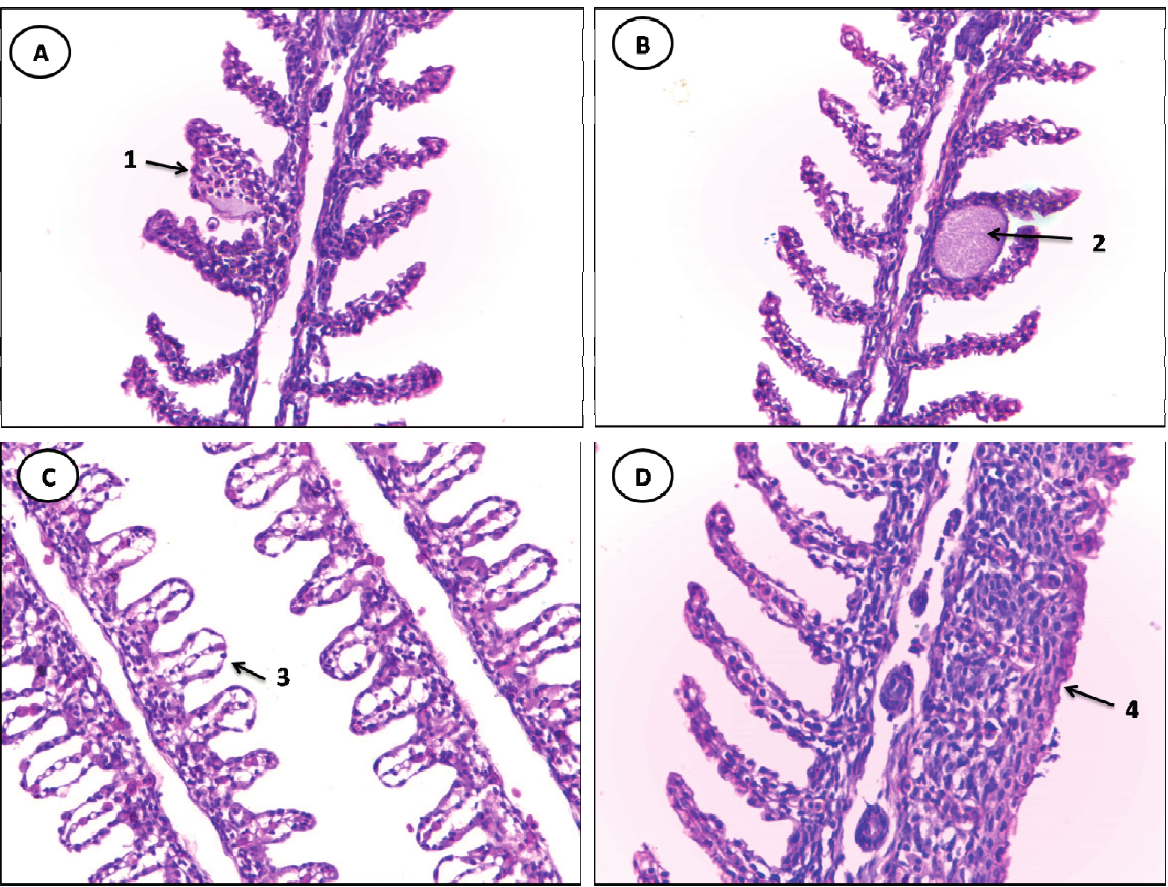
Figure 3. Histological alterations in the gills of Sardinella sp. ( A ) 1: aneurysm. ( B ) 2: parasitic cyst. ( C ) 3: lifting of the respiratory epithelium. ( D ) 4: complete fusion of several lamellae (HE staining, 400×